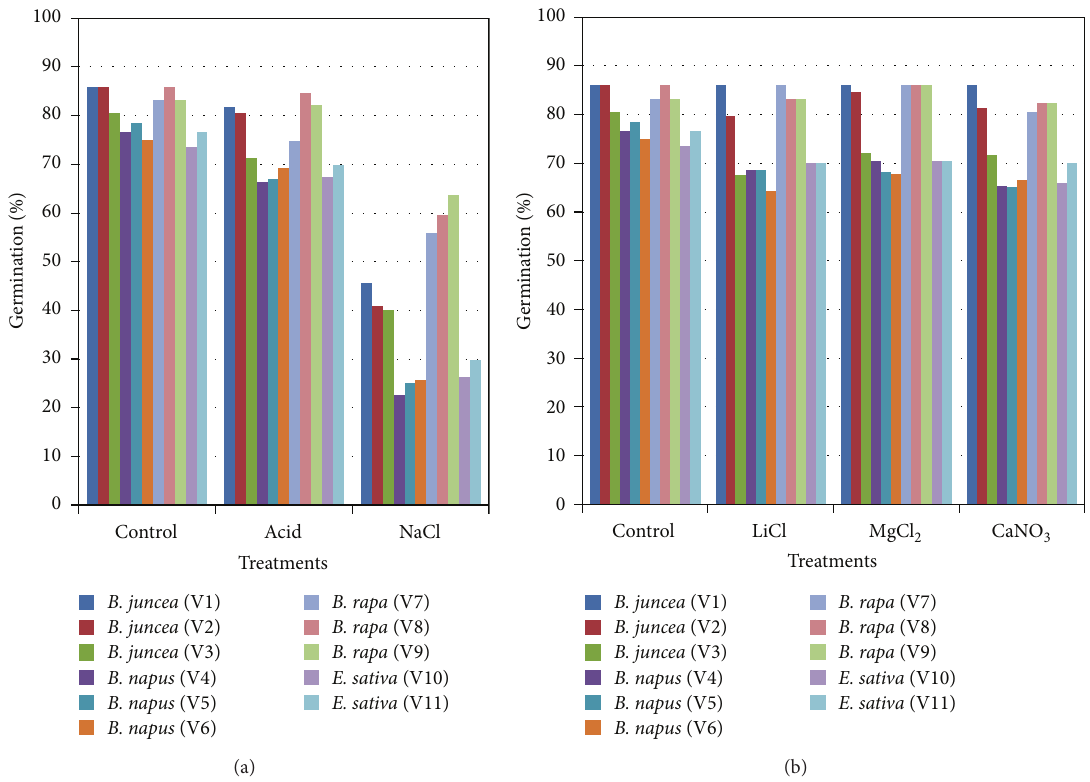
Figure 1: Effect of high and low (a) and intermediate (b) RH on germination percentage of various accessions of Brassica spp. and Eruca sativa